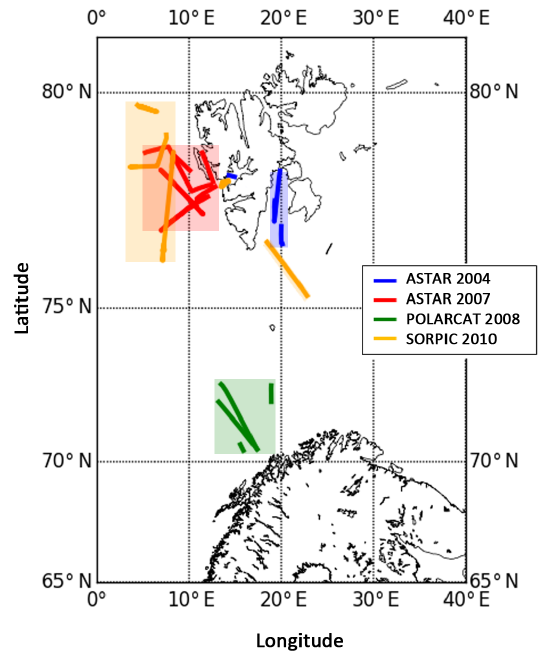
Figure 1. Location of the MPC measurements during the ASTAR, POLARCAT and SORPIC